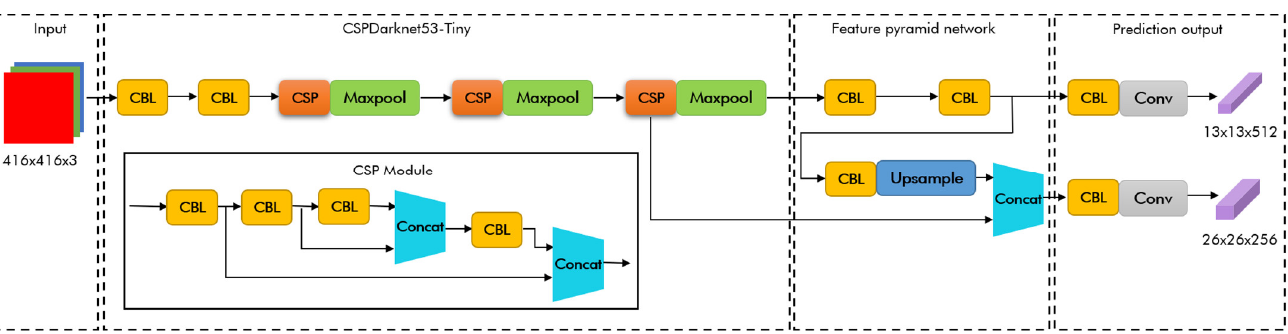
Figure 1. YOLOv4-tiny network structure.